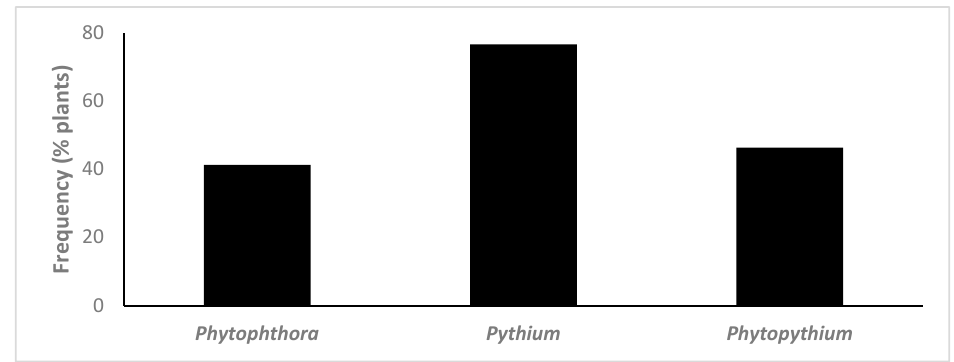
Figure 1. Frequency of detection of Phytophthora , Pythium and Phytopythium species in plants using classical isolation methods ( n = 99).